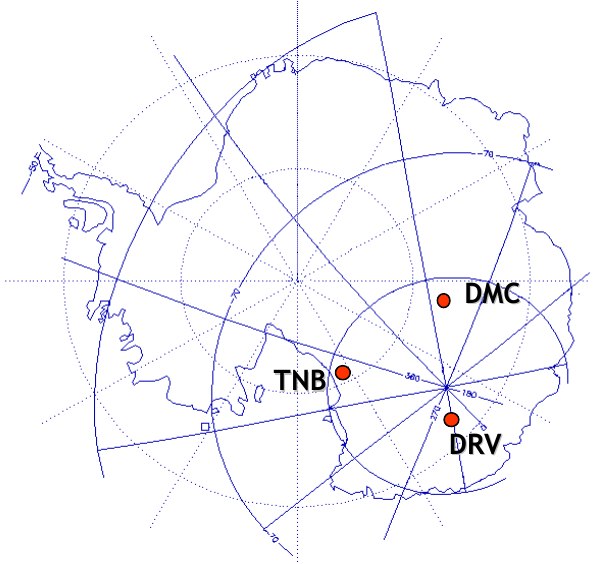
Fig. 1. The location of the three Antarctic observatories TNB, DRV and DMC, together with the geographic (dashed lines) and cor- rected geomagnetic (solid lines) coordinate systems over Antarc-